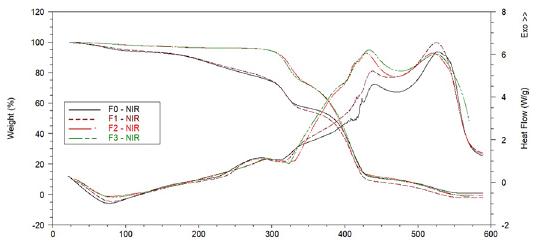
Figure 5. DSC curves of the non irradiated (NIR) blends